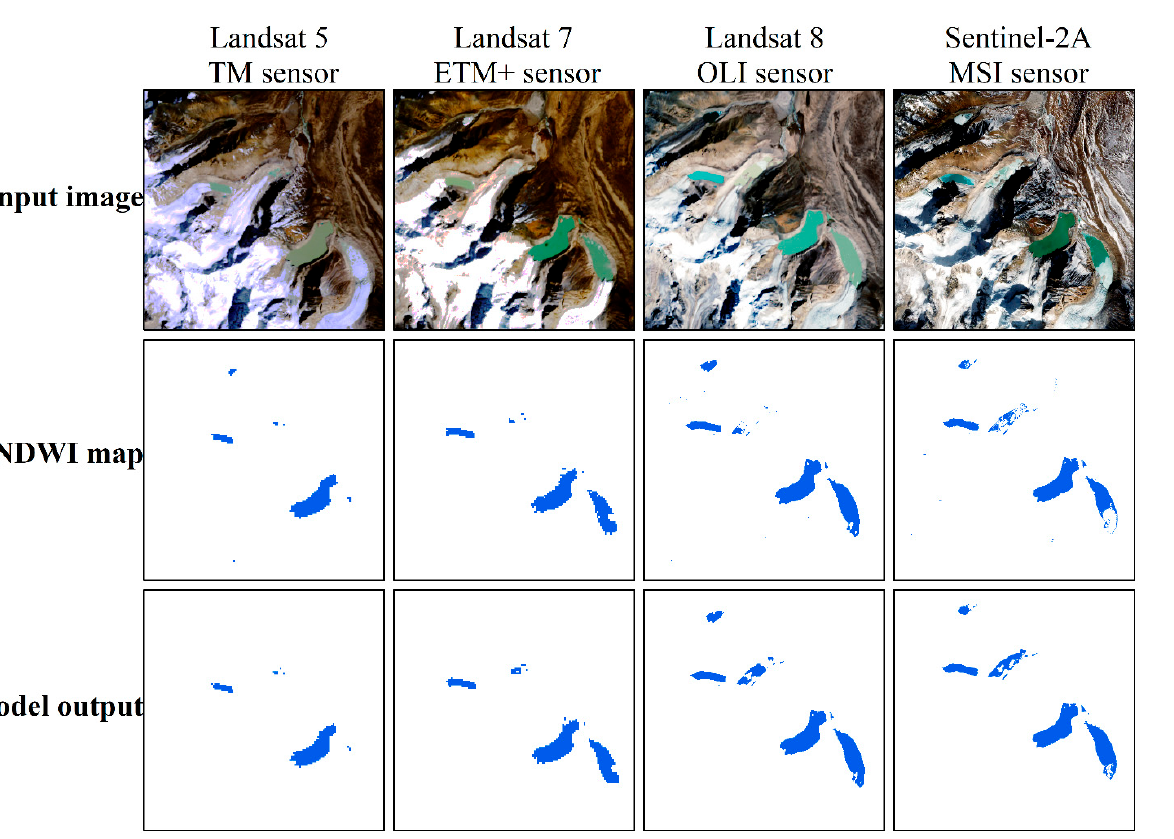
Figure 8. The visualization results of our model SimGL conducting on four different RS images. The blue areas are extracted lakes. The first row shows the RS images from Landsat-5 TM, Landsat-7 ETM+, Landsat-8 OLI and Sentinel-2A. The second row is the segmentation results by thresholding the NDWI map with a value of 0.6, the pixels great than this value will be marked as lake pixels. The third row is the testing results using our model SimGL.